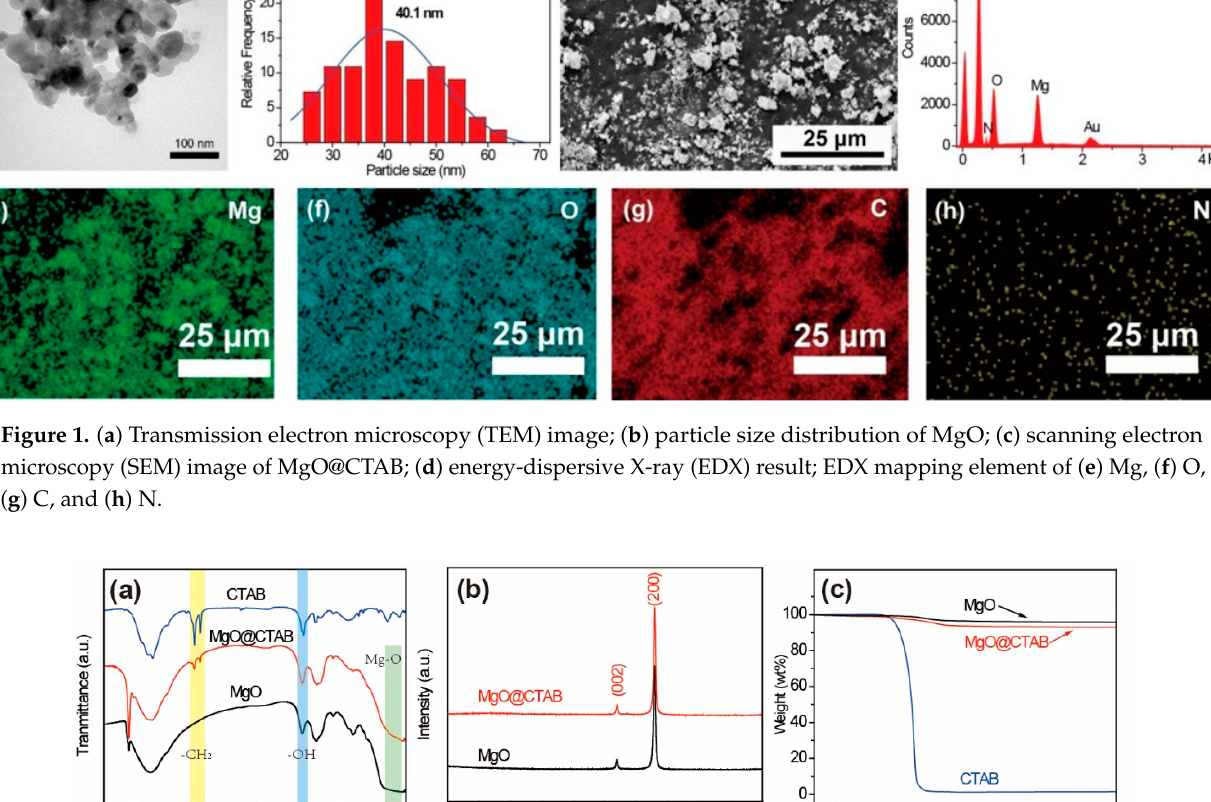
Figure 1. ( a ) Transmission electron microscopy (TEM) image; ( b ) particle size distribution of MgO; ( c ) scanning electron microscopy (SEM) image of MgO@CTAB; ( d ) energy-dispersive X-ray (EDX) result; EDX mapping element of ( e ) Mg, ( f ) O, ( g ) C, and ( h ) N.